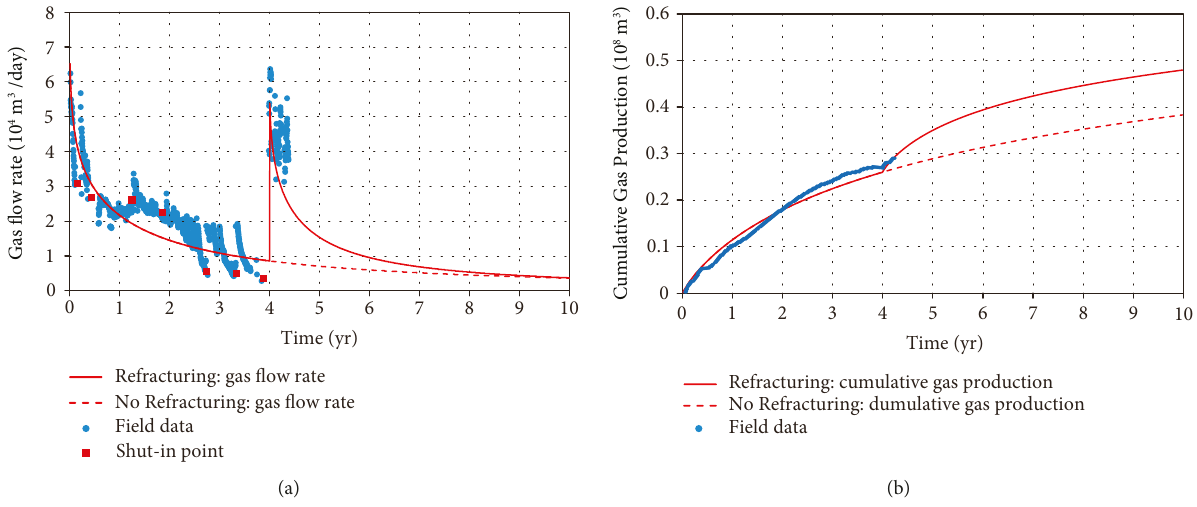
Figure 3: Comparison of simulation results with fi eld data: (a) gas fl ow rate and (b) cumulative gas production.